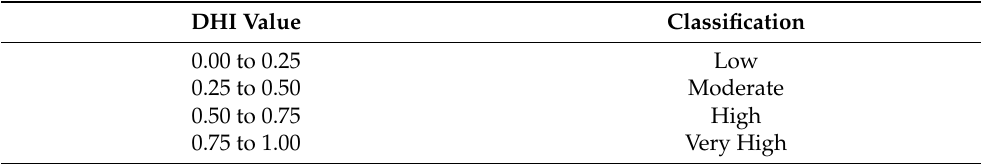
Table 2. The classification of DHI for drought hazard assessment.